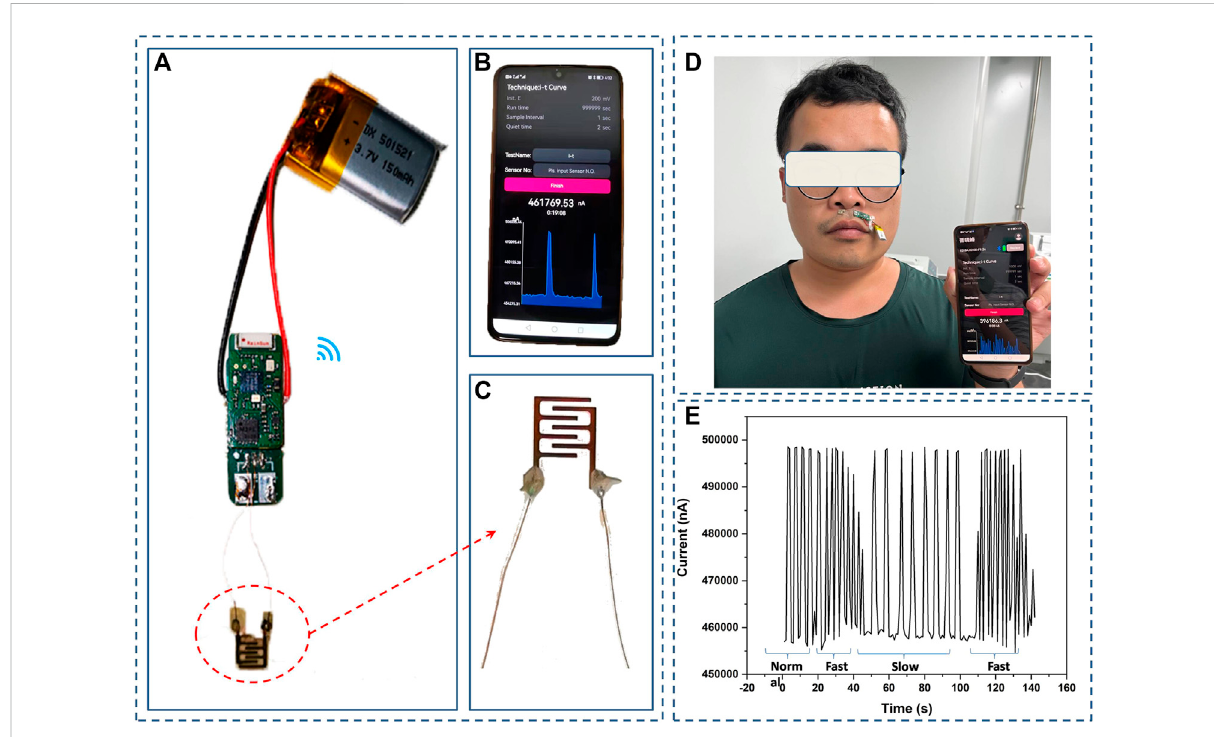
FIGURE 4 (A) Photograph of the fully integrated wearable humidity sensor, (B) Photograph of App-assisted smartphone as a wireless receptor, (C) Photograph of humidity sensor connected by conductive silver paste between wire and LCP-copper interdigital electrode, (D) Photograph of the